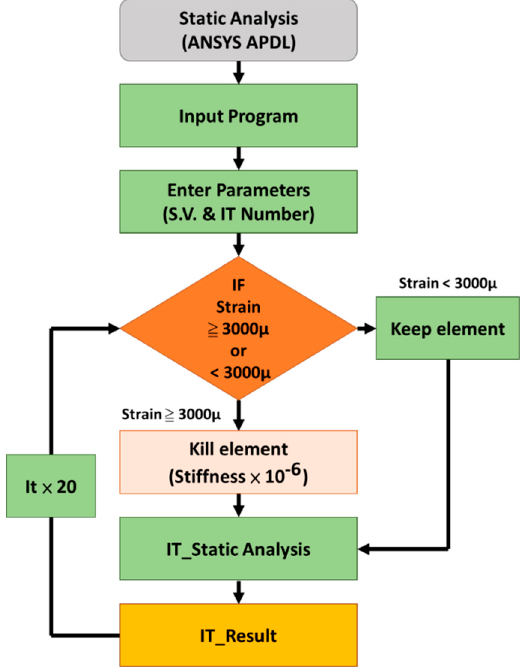
Figure 2. Element death iterative calculation in ANSYS. IT: iteration of calculation .